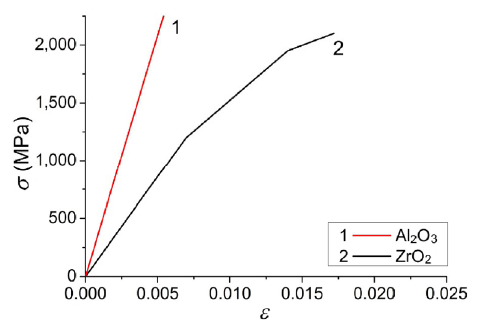
Fig. 13 Stress-strain diagrams for alumina (1) and Y-TZP (2).